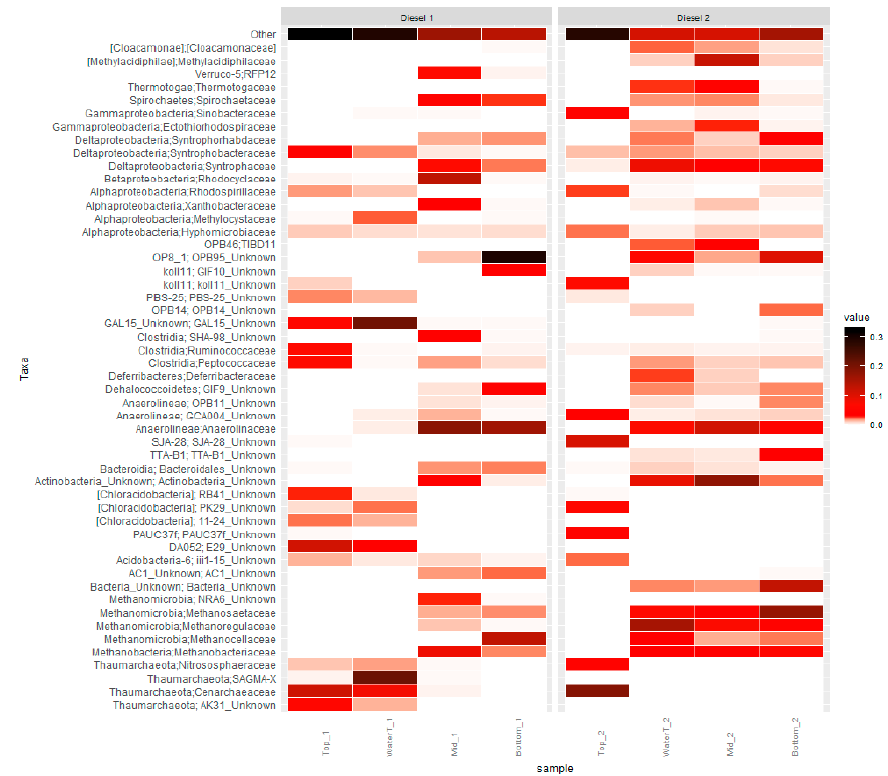
Figure 3. Most abundant taxa in diesel-contaminated cores. Heatmap of the most abundant (>2%) taxa in the diesel-contaminated cores, based on next generation sequencing of 16S rRNA genes.